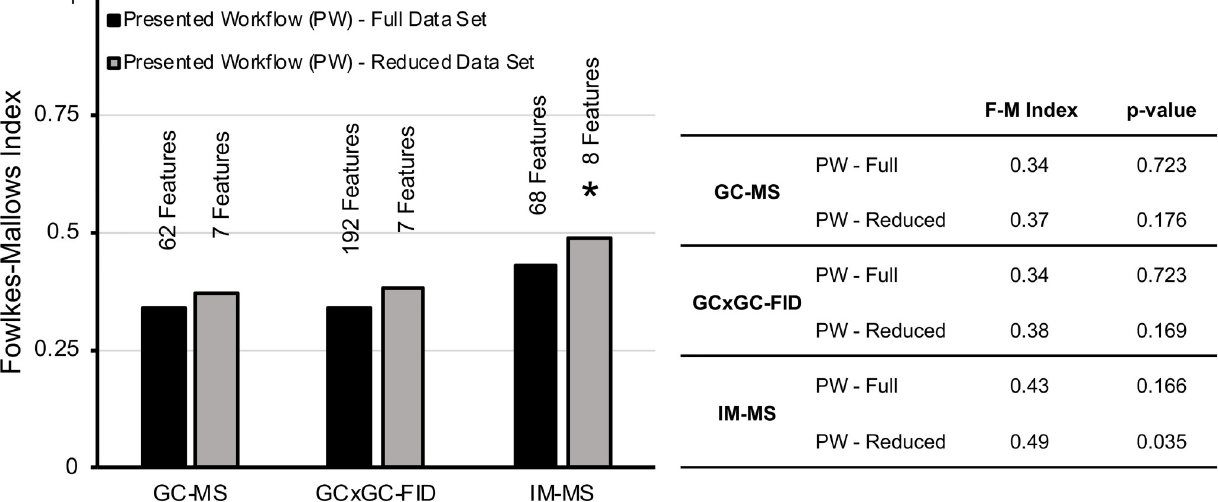
PLOS ONE | https://doi.org/10.1371/journal.pone.0223517 October 10,